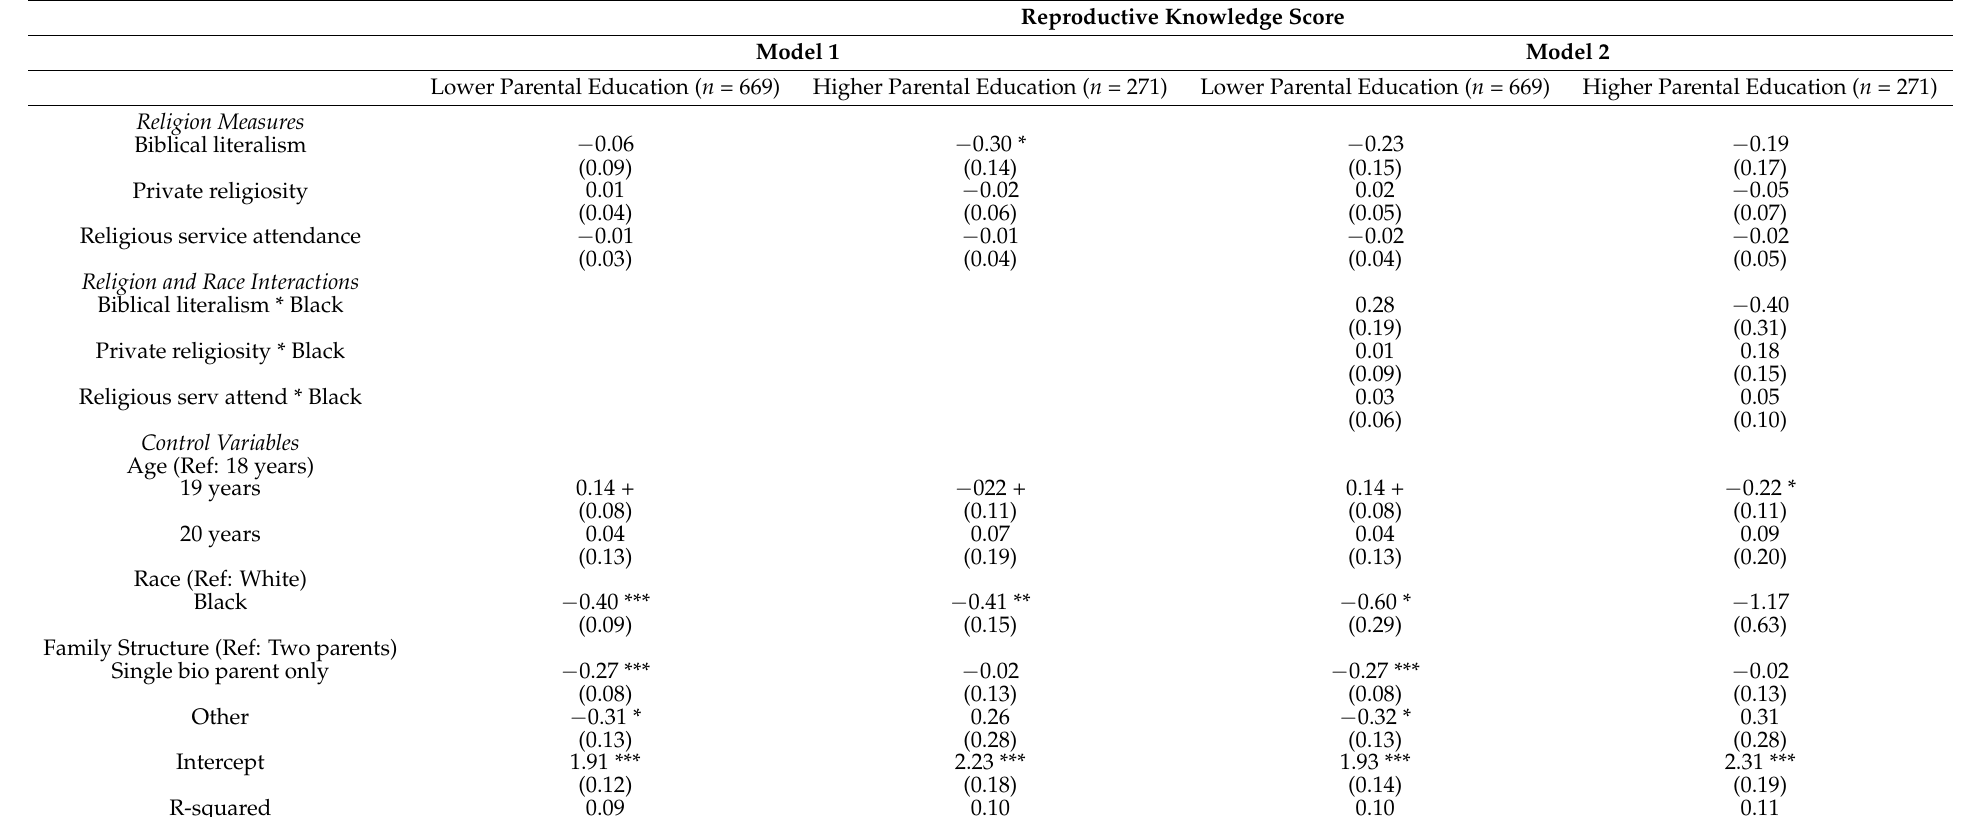
Table 3. OLS Regression Models of Relationships between Religion Measures and Reproductive Knowledge Score, Separate by Parent Education, and Interactions with Race